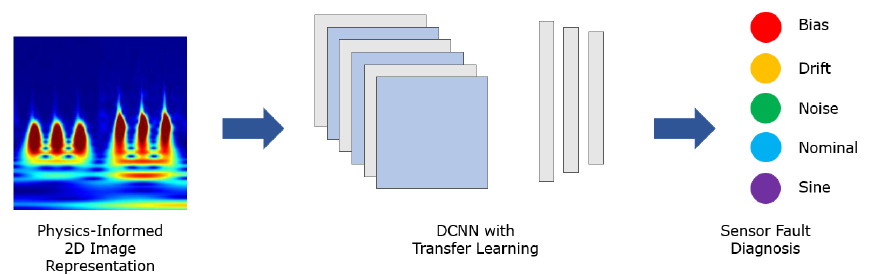
Figure 11. Workflow representation for DCNN transfer learning